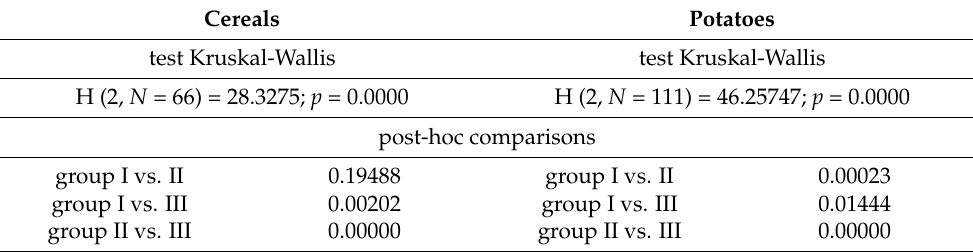
Table 3. The results of the Kruskal-Wallis multiple comparisons test performed to analyze the dy- namics of the changes in the yield of selected crops (according to the data from specific voivodships). Cereals Potatoes test Kruskal-Wallis test Kruskal-Wallis H (2, N = 66) = 28.3275; p = 0.0000 H (2, N = 111) = 46.25747; p = 0.0000 post-hoc comparisons group I vs.